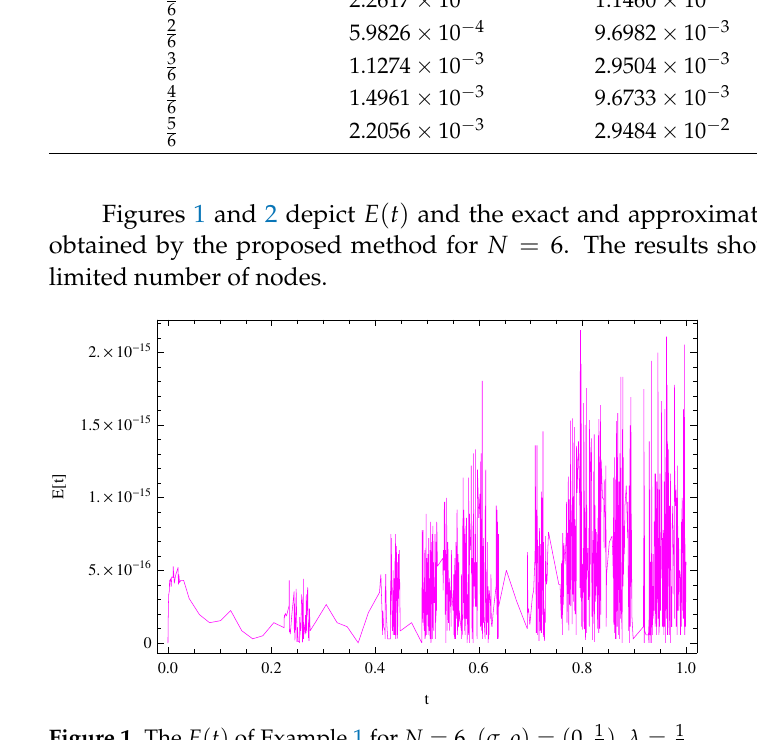
Figure 1. The E ( t ) of Example 1 for N = 6, ( σ , ρ ) = ( 0, 1